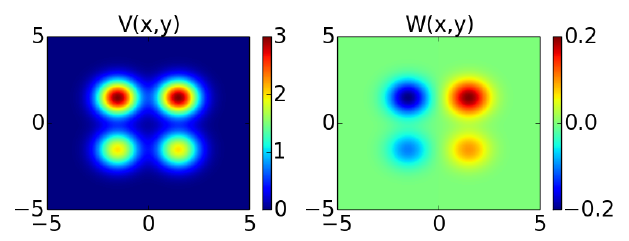
Figure 1. The plots show the spatial distribution of real ( V , left panel) and imaginary ( W , right panel) parts of the potential U with x 0 = y 0 = 1.5.